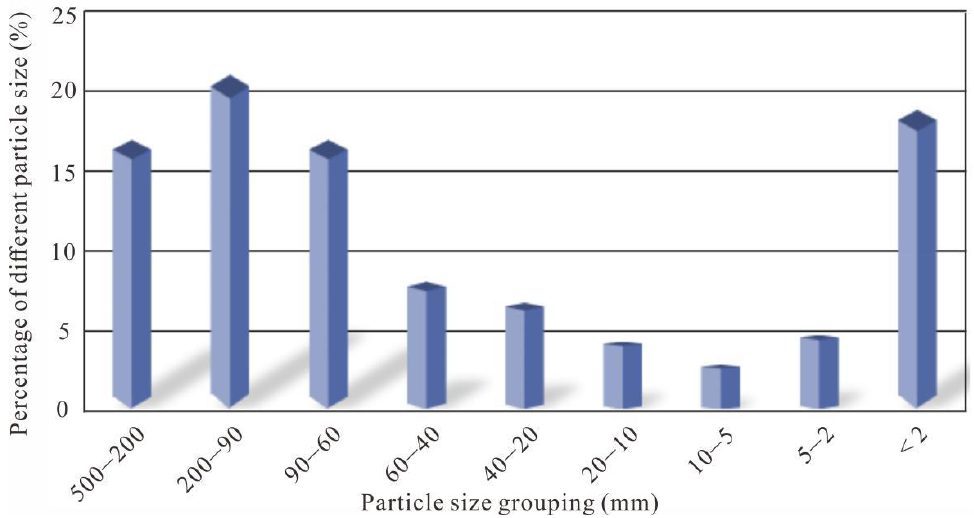
Figure 4. Different particle size distribution of glacial till samples.